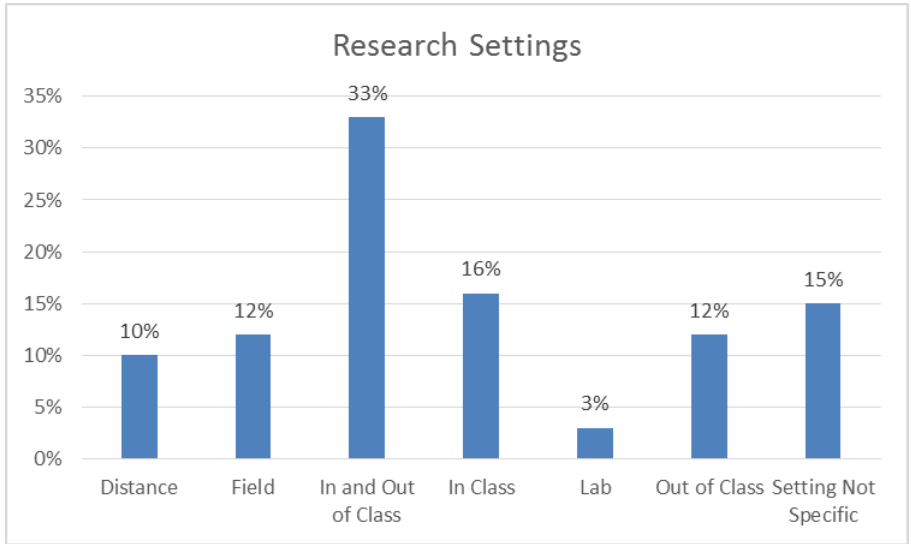
Figure 3. Distribution of studies by research